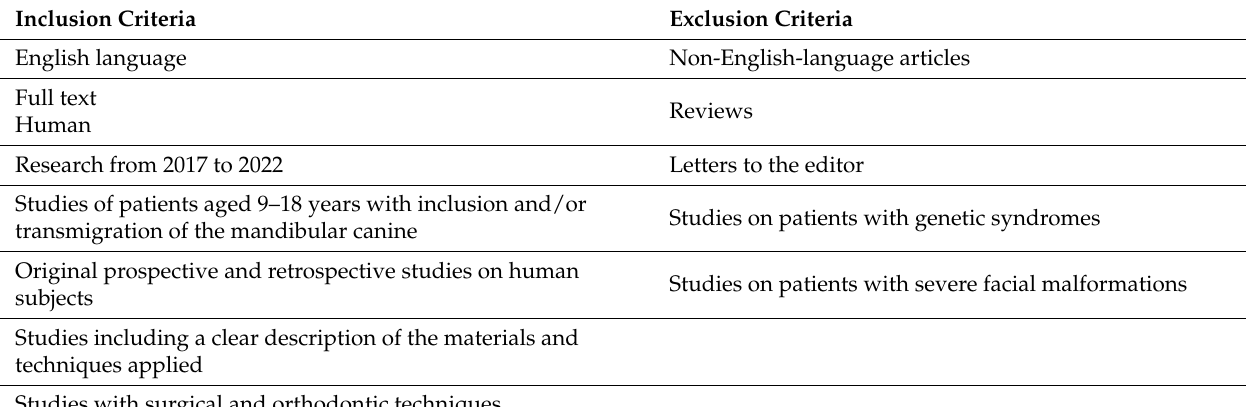
Table 2. Inclusion and exclusion